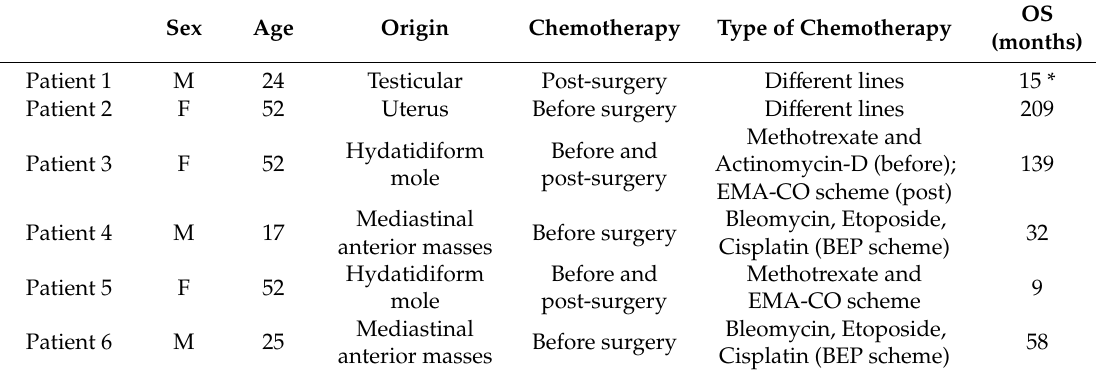
Figure 5. Descriptive timeline of the six cases of choriocarcinoma operated in the last 20 years at our institute. Table 1. Patient clinical data and Table 1. Patient clinical data and characteristics.